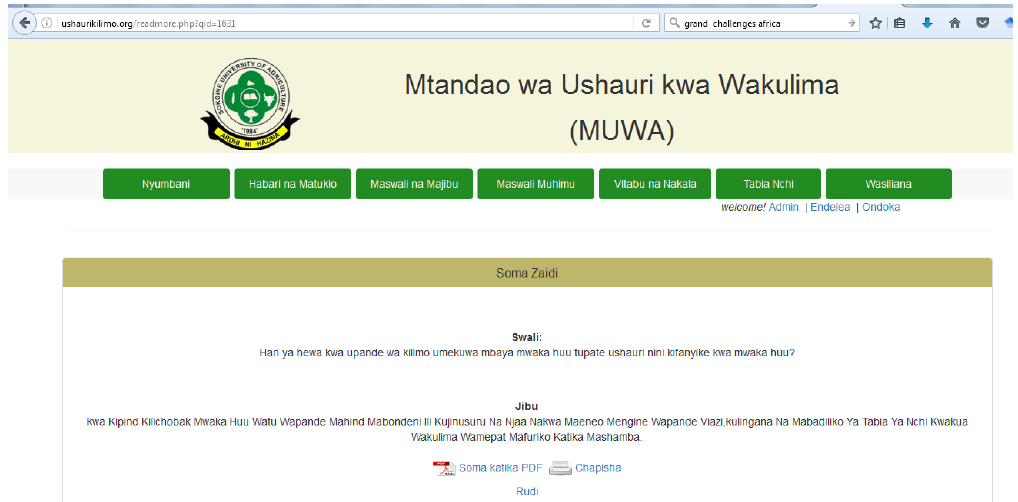
Figure 7 . Advice from extension agent about what to farm after flooding has occurred in